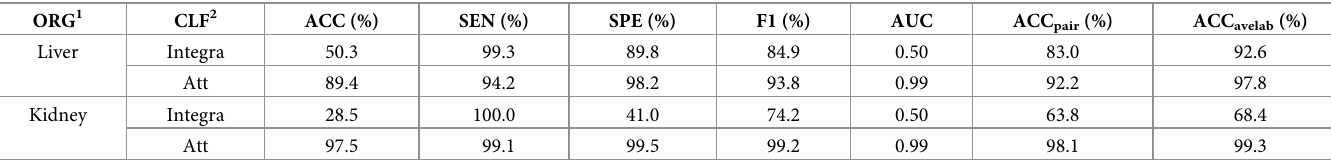
Table 10. The performance of the integrative model and Att-RethinkNet. ORG 1 CLF 2 Liver Integra Kidney Integra